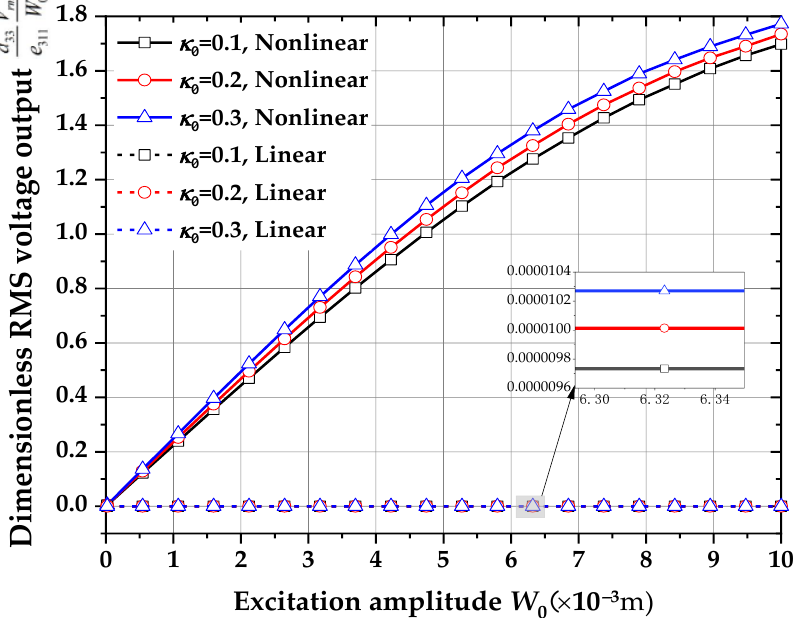
V rms ) – excitation amplitude ( W 0 ) e 311 W max a V W ) – excitation amplitude ( 0 e W